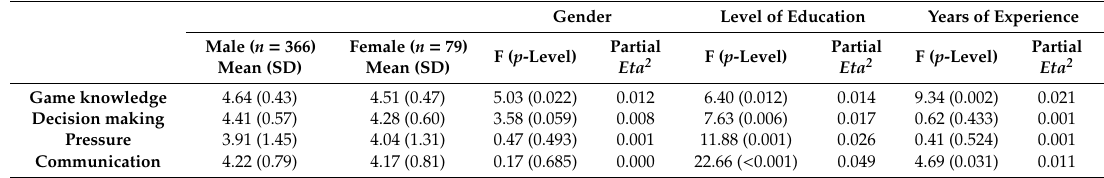
Table 3. Mean score in REFS subscales across male and female referees.